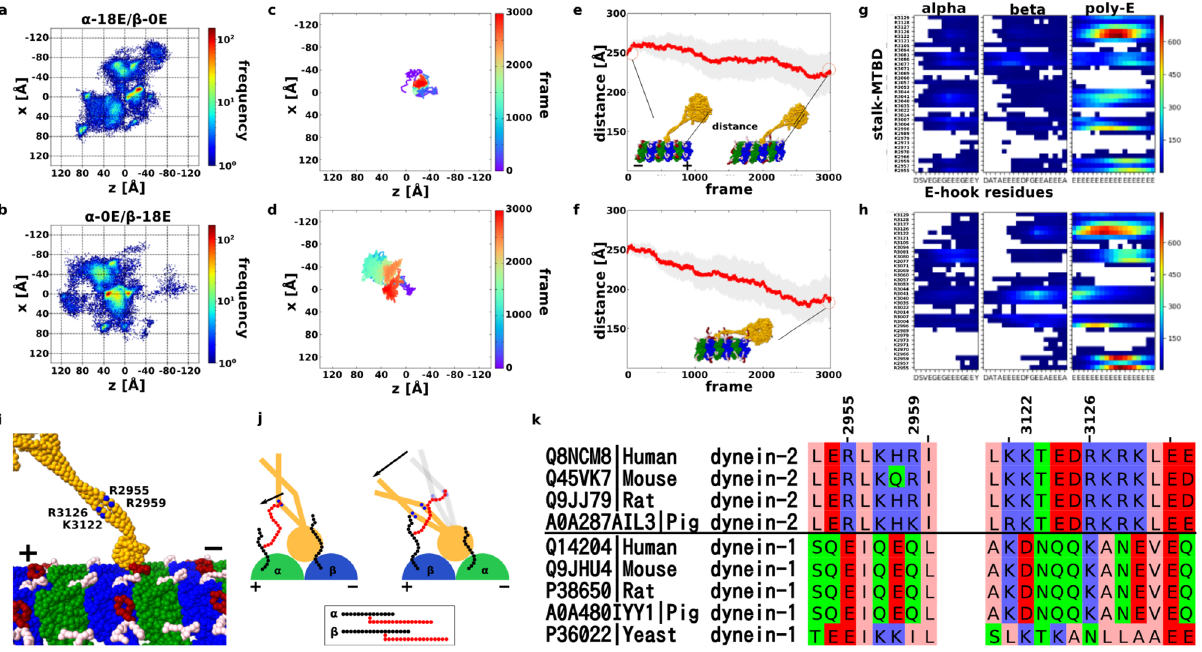
Figure 4. Low-affinity state dynein with long poly-E MT. ( a , b ) Heat map of the position of the low-affinity state MTBD on the long poly-E MT, with 20 trajectories overlaid. The coloring method is same with Fig. 1d. ( a ) is in the α-18E/β-0E case, and ( b ) is in the α-0E/β-18E case. ( c , d ) Representative trajectory of MTBD on the poly-E MT. The coloring method is same with Fig. 1b. ( c ) is in the α-18E/β-0E case, and ( d ) is in the α-0E/β-18E case. ( e , f ) The trajectory of the average distance between the tip of the linker to the closest tubulins. The average distance for each frame is red, and 95% confidence interval are gray. ( g , h ) Residue-by-residue contact maps of CTT and poly-E with ARG or LYS residues on stalk-MTBD. Highly contacted pairs are colored red, lower are blue, and no contact pairs box are white. ( g ) and ( h ) is made from 20 trajectories in α-18E/β-0E and α-0E/β- 18E setup, respectively. ( i ) The highest contact residues on the stalk-MTBD region; R2955, R2959, K3122, and R3126. Especially, R2955 and R2959 are specific contact residues in (0, 18) case. ( j ) Cartoons for understanding poly-E contact features. MTBD, α-tubulin, and β-tubulin colored orange (gray), green, and blue. CTT is black, and poly-E is red. ( k ) Sequence alignment of dynein-1 and -2 from different